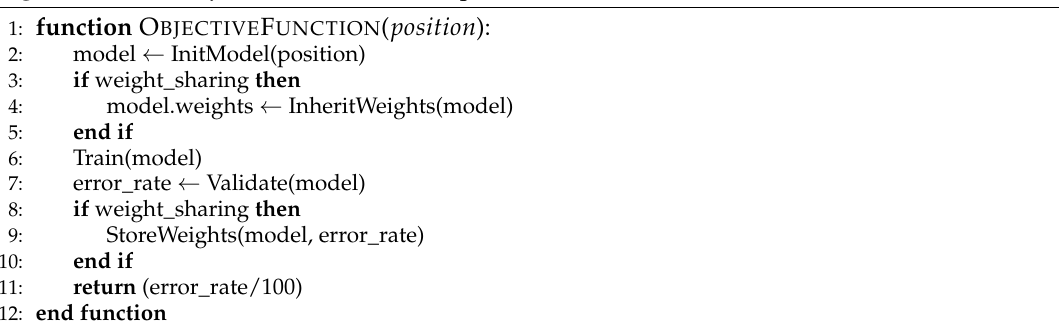
Algorithm 1 The objective function to be optimised.